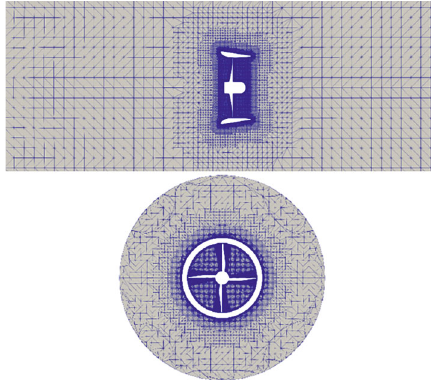
Figure 4: An overview of the computational grid used in numerical solving.